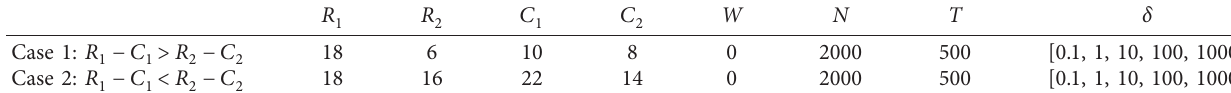
Table 8: Parameter setting considering the change of δ